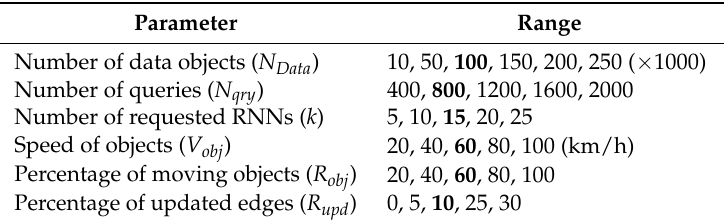
Table 5. Experimental parameter